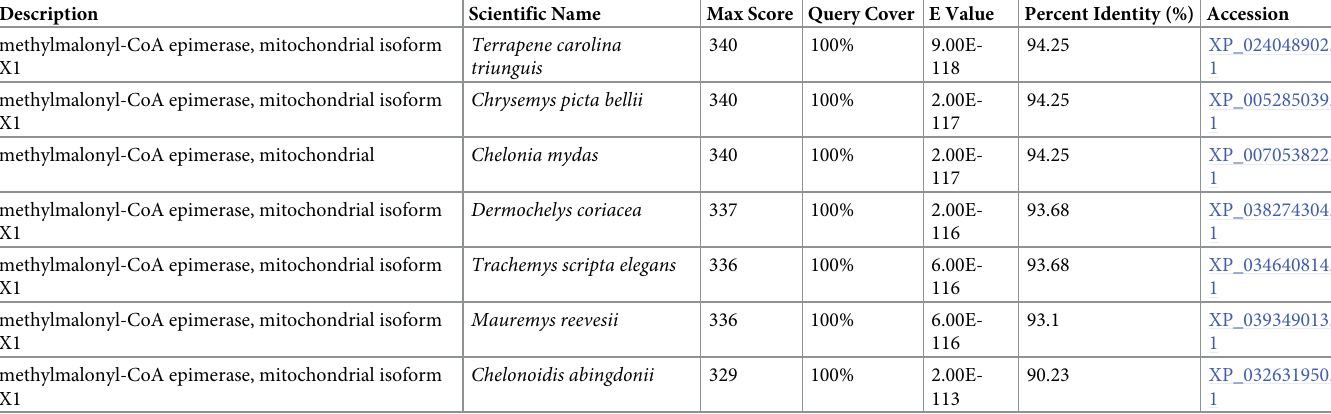
Table 5. BLAST output of the g112.t1 sequence after genome editing. Top hits also predicted mitochondrial methylmalonyl-CoA epimerase with a higher query cover- age, higher percent identity, and lower E